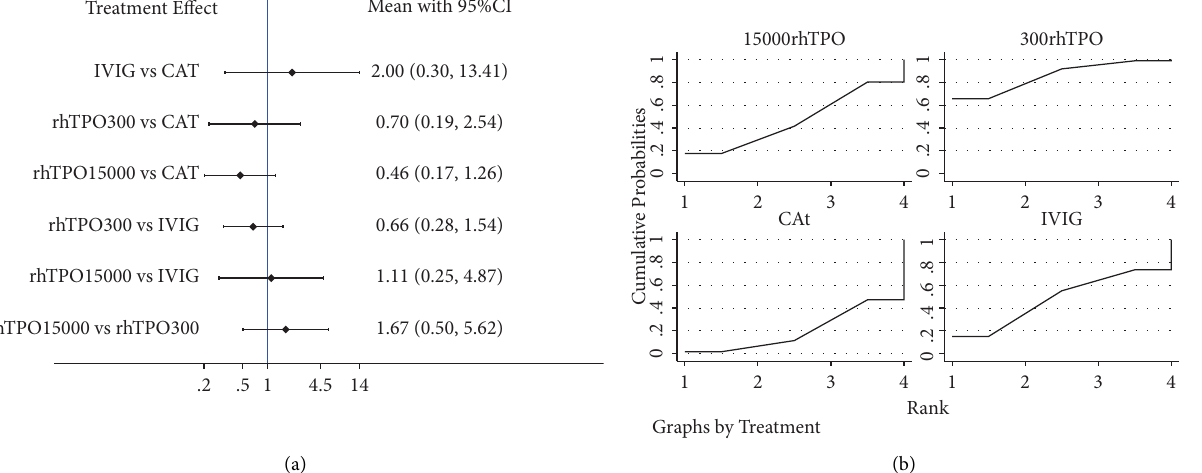
Figure 3: Network meta-analysis of the relative efcacy (a) and the rank probabilities (b) among diferent treatment strategies in terms of 28-day mortality. NAT, no additional treatment; IVIG, intravenous immunoglobulin; rhTPO 300, 300U/kg/d recombinant human thrombopoietin; rhTPO 15000, 15000U/d recombinant human